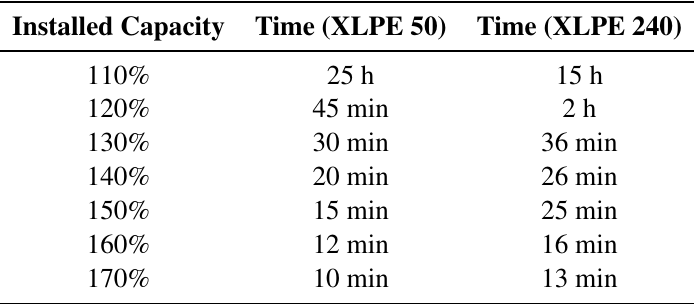
Table 4. Timing temperature rise of 10 ◦